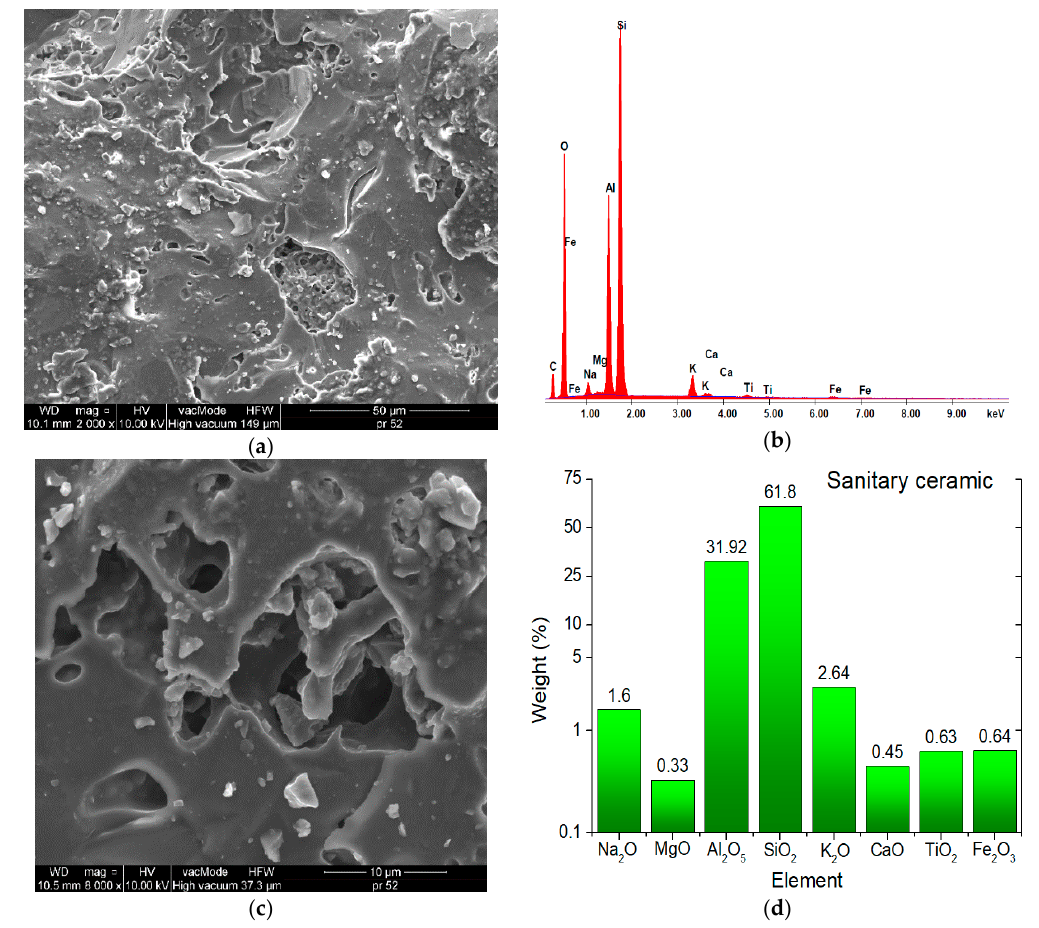
Figure 4. Sanitary ceramics SEM microstructure (2000× and 8000×) and elemental analysis results in the EDS micro area. ( a ) SEM microstructure (2000×); ( b ) composition; ( c ) SEM microstructure (8000×); ( d ) percentage composition. Table 5. CA and SFE values for the mineral–asphalt mixture